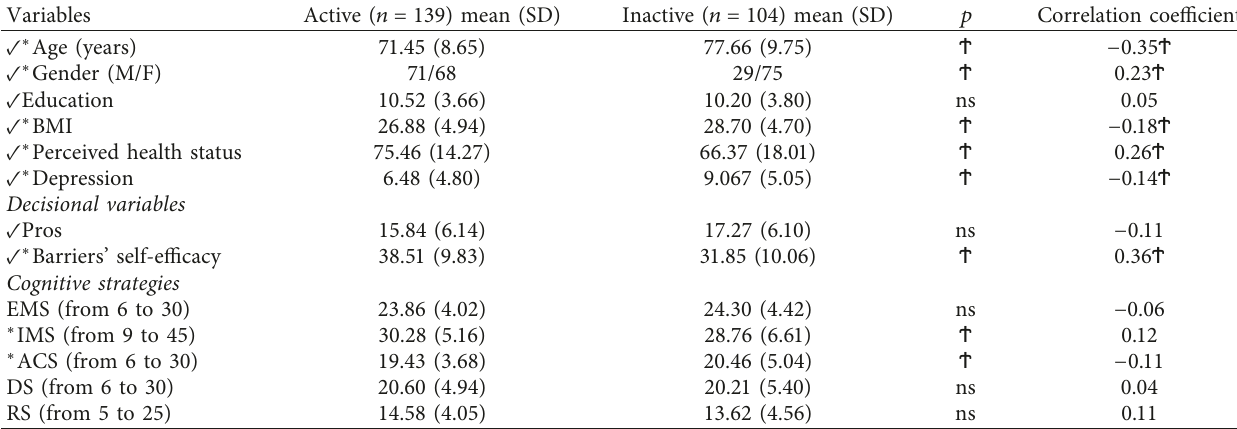
Table 2: Sociodemographic, health, motivational, and cognitive strategies for active versus inactive participants. The last column shows the correlations between the variable and the level of physical activity for the population sample examined in this study ( n � 243).